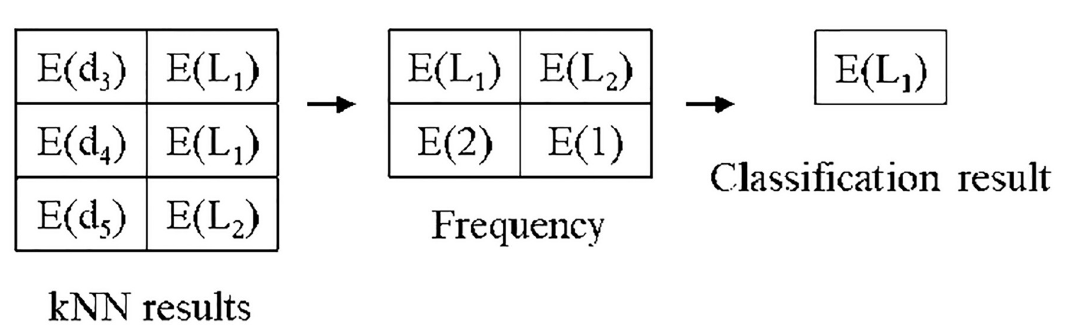
Fig 9. Example of kNN classification